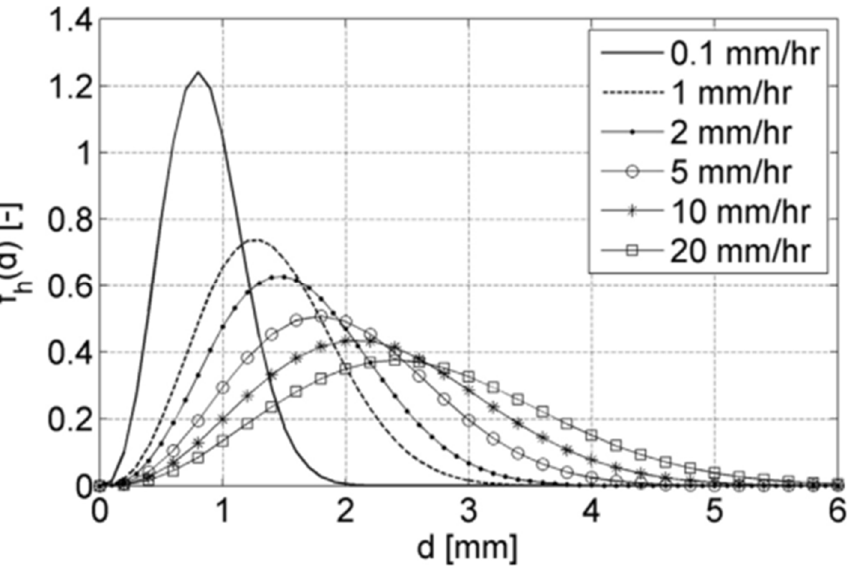
Figure 1. Data diagram of the size distribution of raindrops passing through the horizontal plane under different rain intensities based on best measurement.